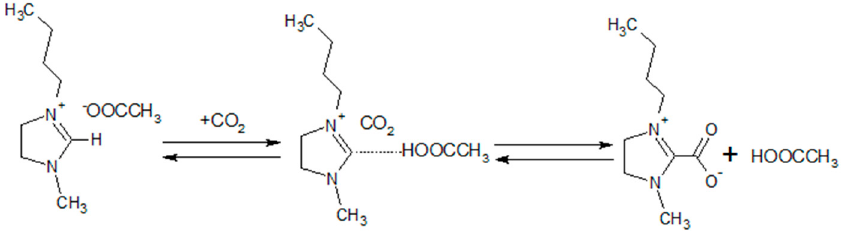
Figure 1. Possible reaction of bmim[OAc] and CO 2 [35,36].